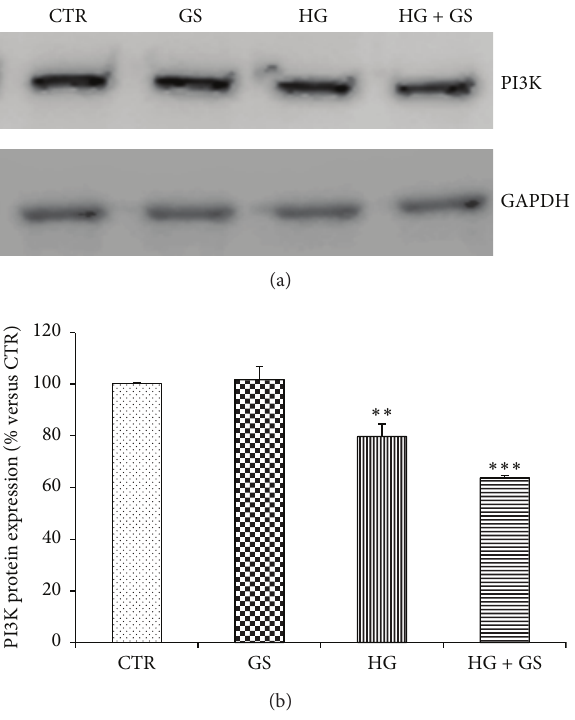
Figure 4: Treatments with GS and HG reduce PI3K protein expression in HIT-T15 cells. (a) HIT-T15 cells were cultured for 5 days in media containing 5.6 mmol/L (CTR) or 11.1mmol/L glucose (HG) supplemented with GS. Then cells were lysed and tested for protein expression of PI3K. Representative western blot analysis. (b) Quantification of densitometries of western blot bands. Data were expressedasmean ± SEoffoldinductionrelativetoGAPDH( 𝑛 = 3 ). ∗∗ 𝑃 < 0.01 and ∗∗∗ 𝑃 < 0.001 versus